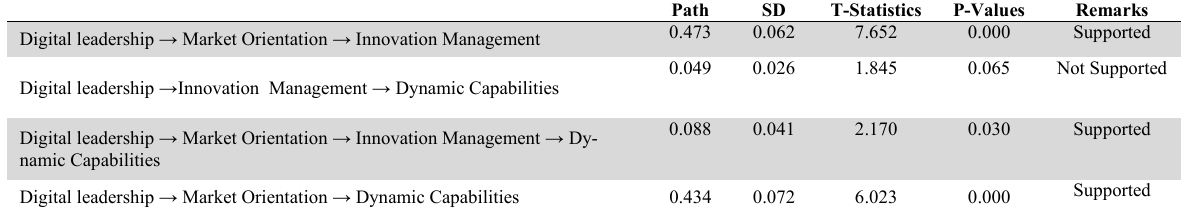
Simultaneous Hypothesis Testing Result